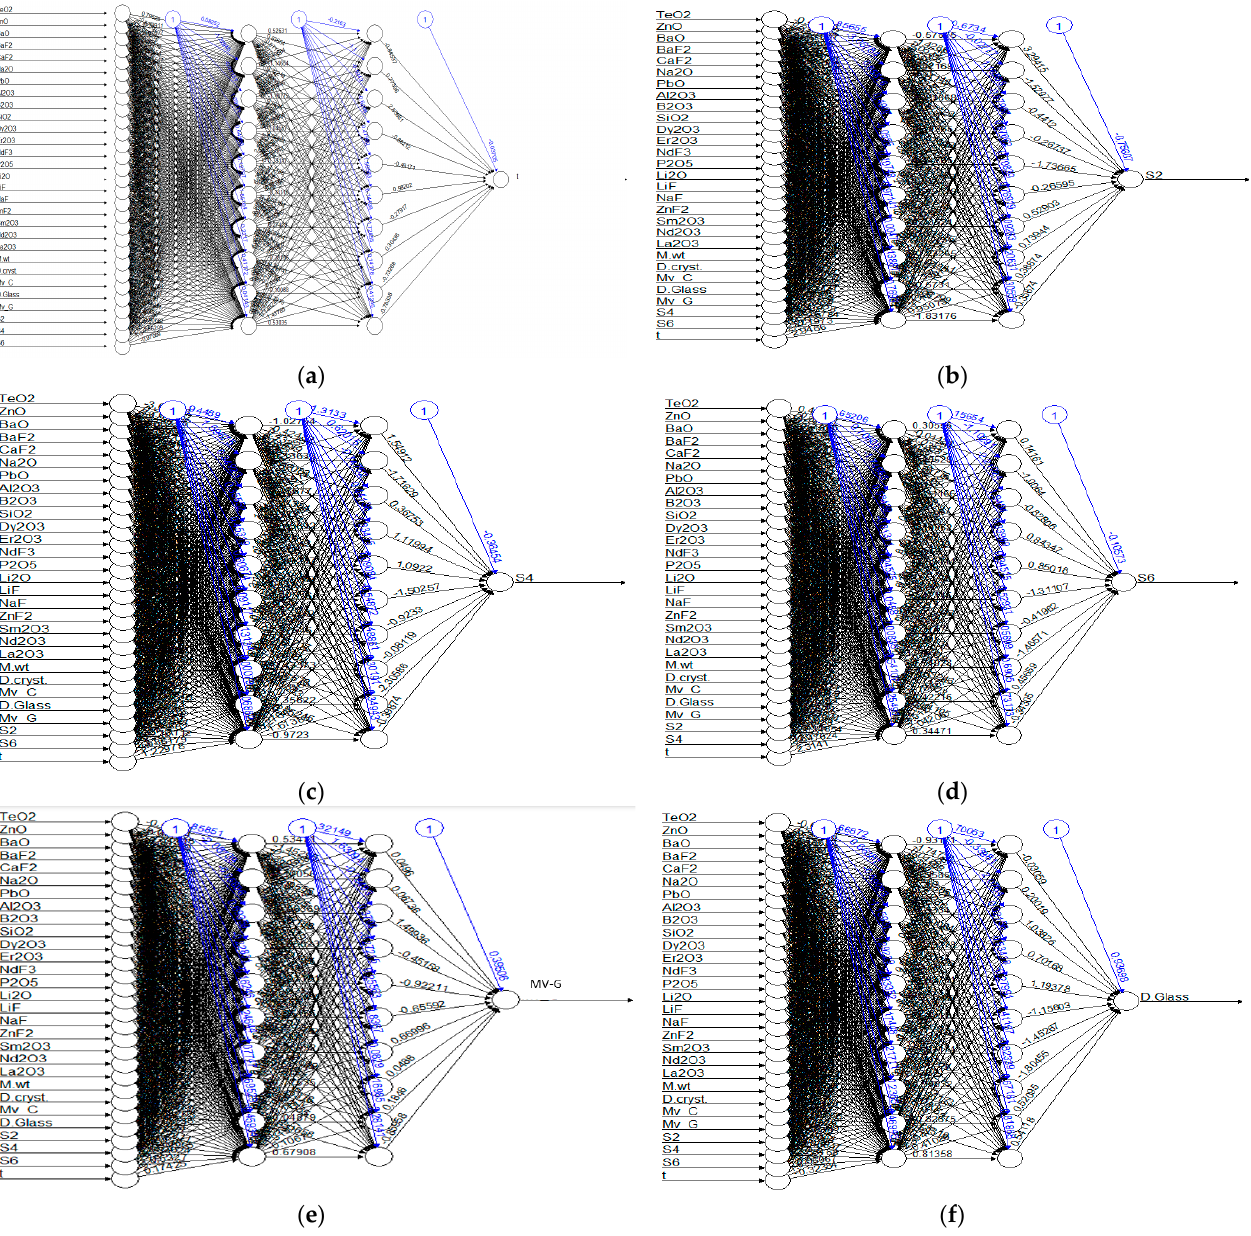
Figure 2. ANN architecture for all outcomes. ( a ) ANN architecture for forecasting the radiative lifetime, T. ( b ) ANN architecture for forecasting S2. ( c ) ANN architecture for forecasting S4. ( d ) ANN architecture for forecasting S6. ( e ) ANN architecture for forecasting Mv_G. ( f ) ANN architecture for forecasting D.Glass.